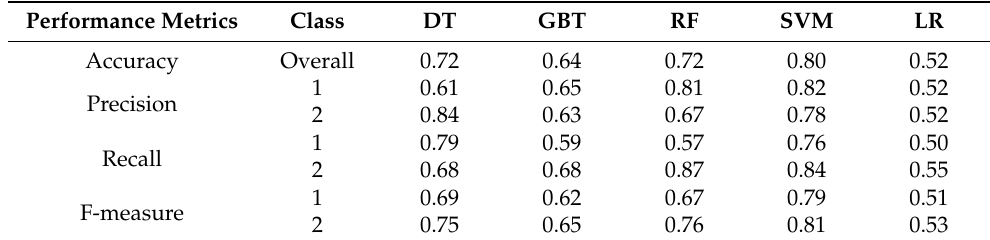
Table 10. Performance metrics of all selected models in the test set. Performance Metrics